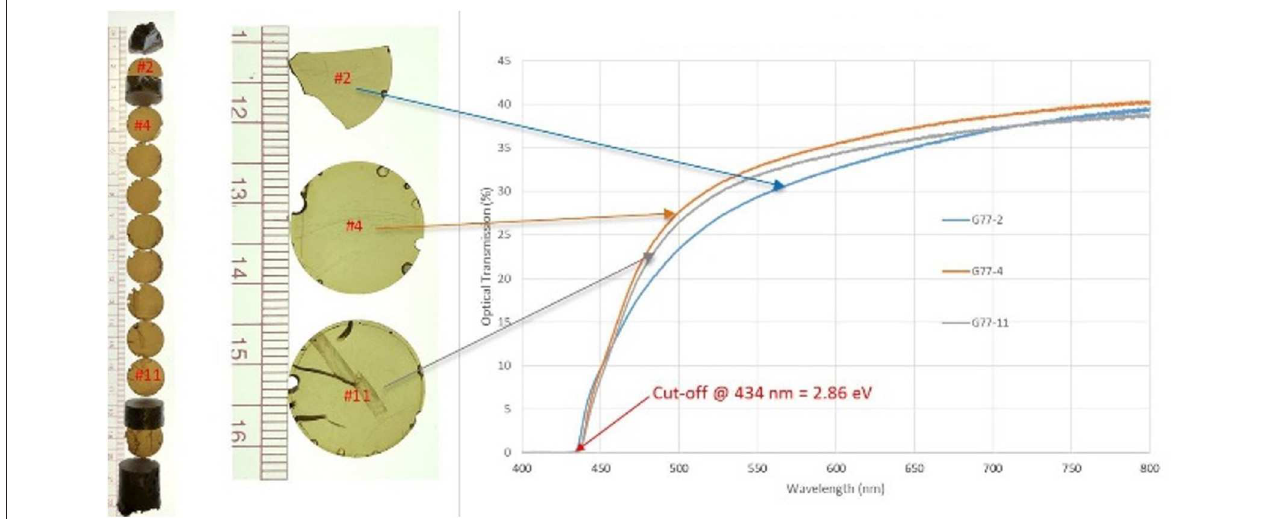
FIGURE 6 | Optical transmission spectra for 0.7mm thick LiInSe 2 crystals sliced from ingot G77. The estimated bandgap is at 434nm, equivalent to 2.86 eV.